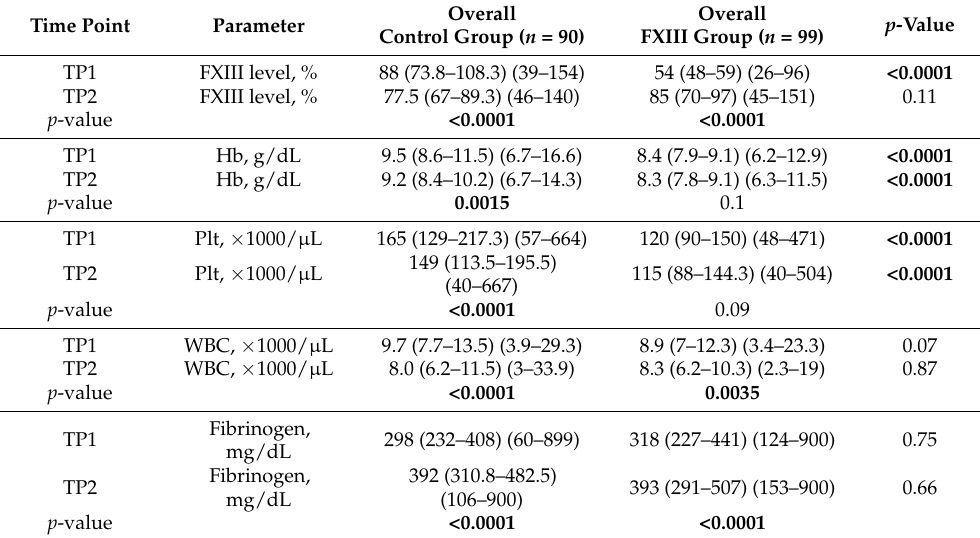
Table A2. Laboratory parameters of all patients ( n = 189) at the two consecutive time